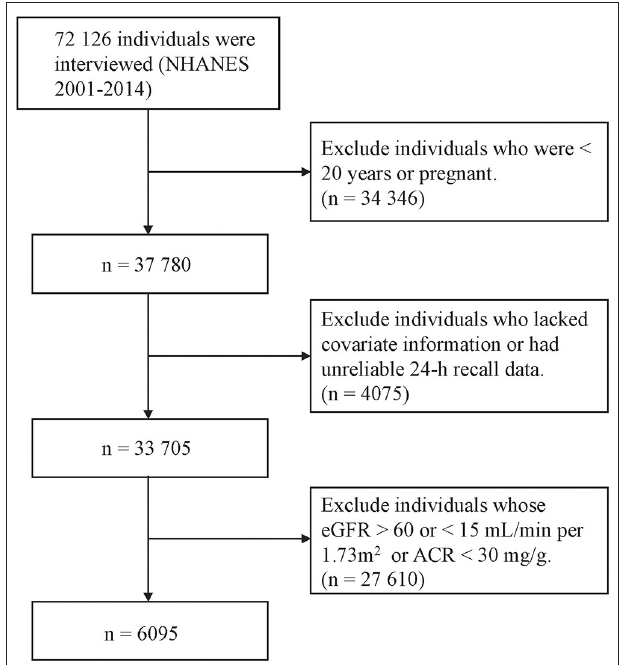
FIGURE 1 | Flow diagram of the selection of eligible participants, National Health and Nutrition Examination Survey